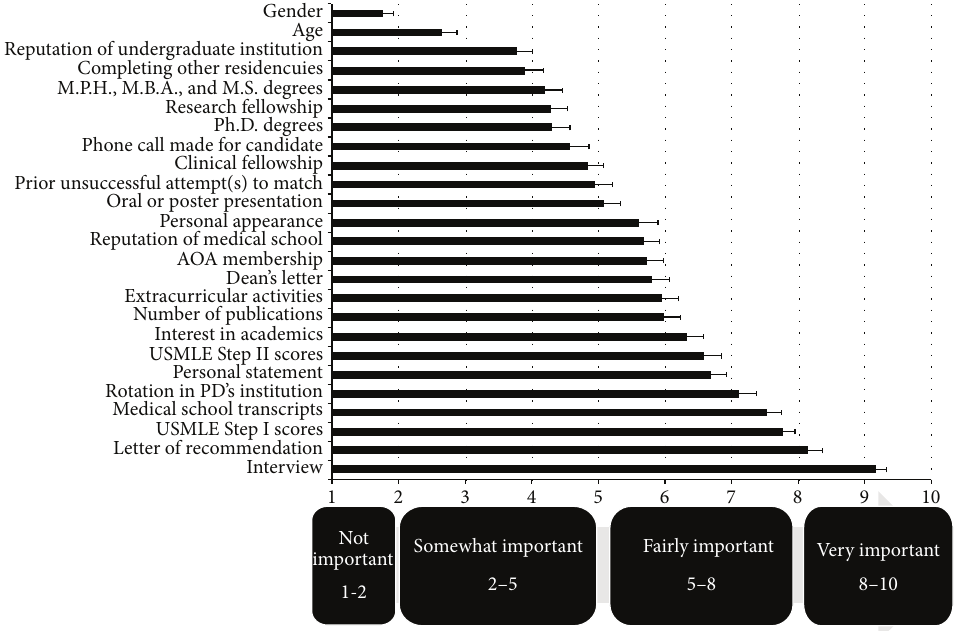
Figure 1: The graphical demonstration of the ranks of the 25-item residency selection